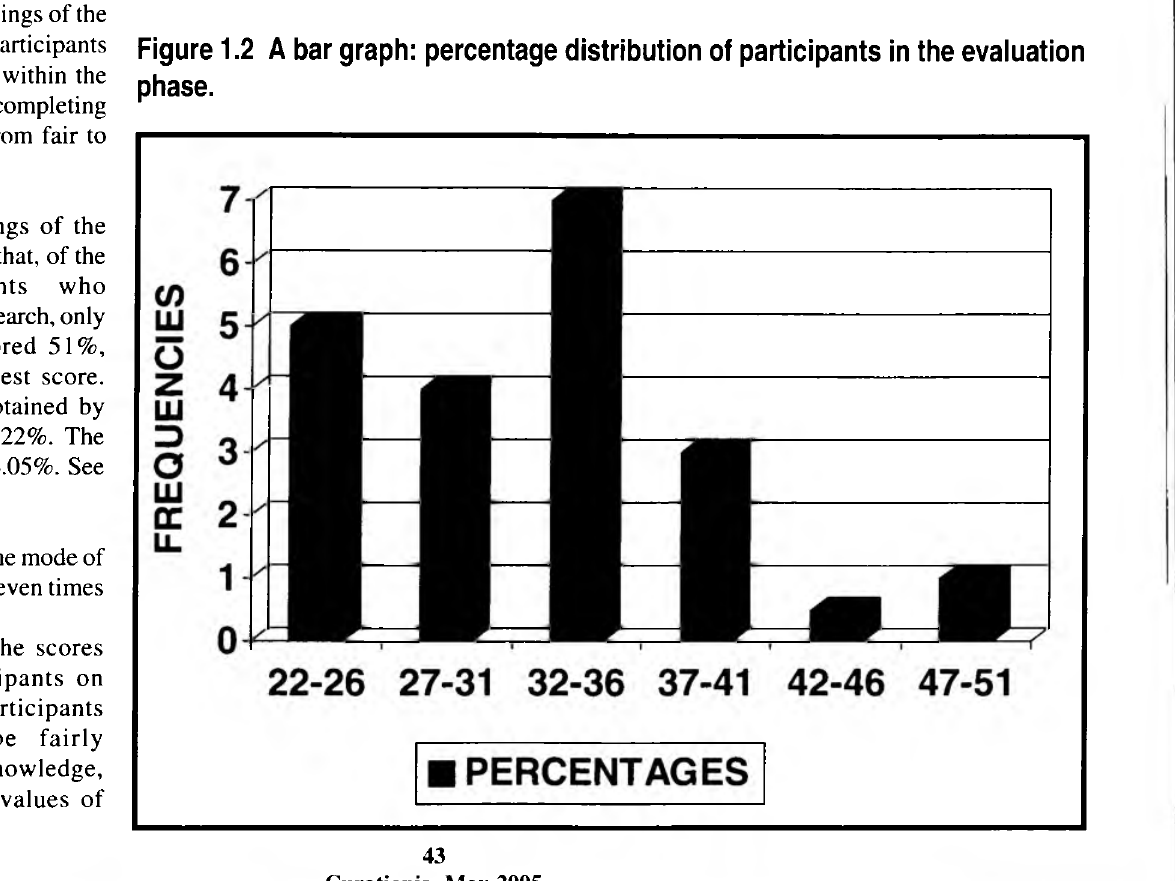
Figure 1.2 A bar graph: percentage distribution of participants in the evaluation